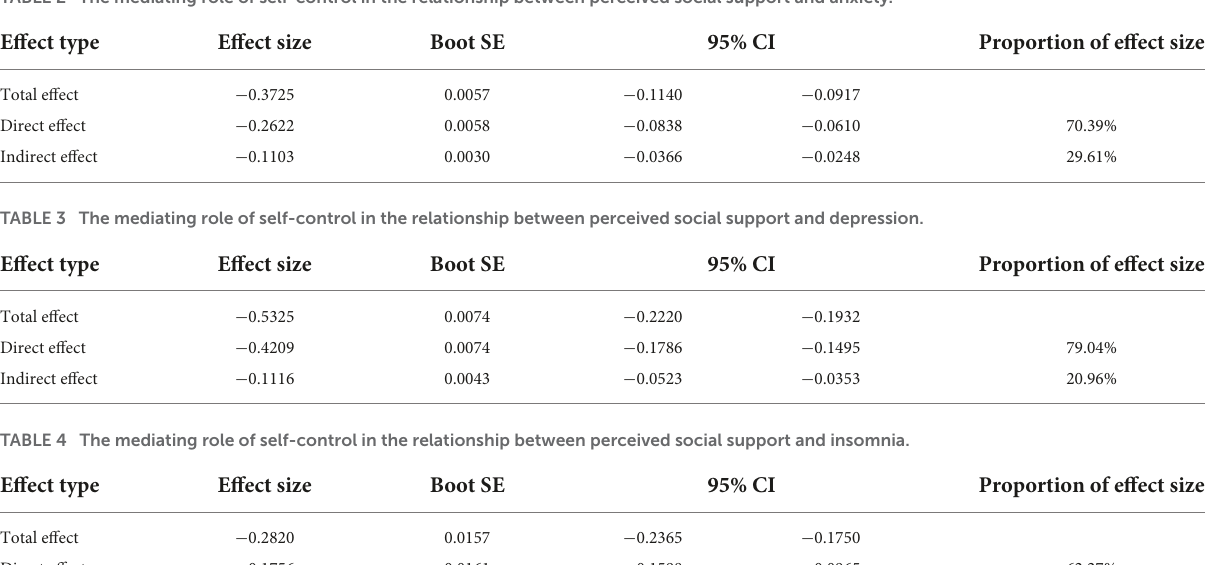
TABLE 2 The mediating role of self-control in the relationship between perceived social support and anxiety.